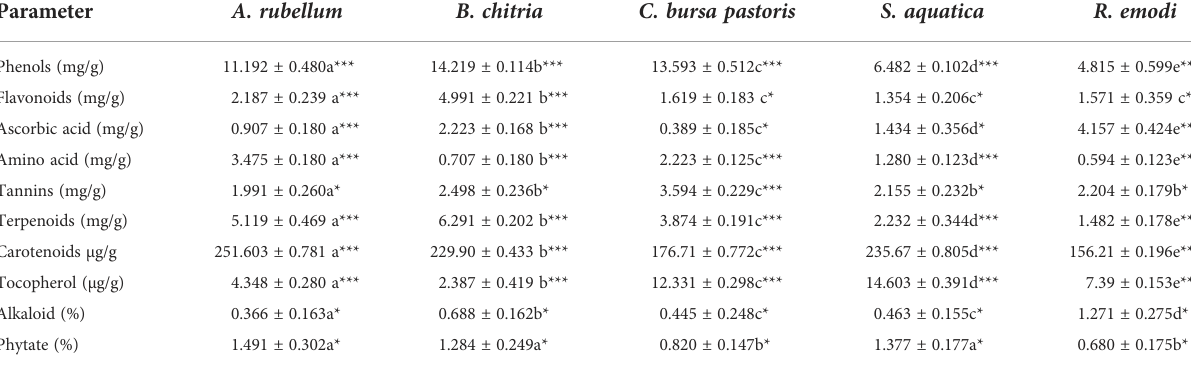
TABLE 3 Phytochemical compositionof Allium rubellum, Berberis chitria, Capsella bursa-pastoris, Stellaria aquatica, and Rheum emodi. Parameter